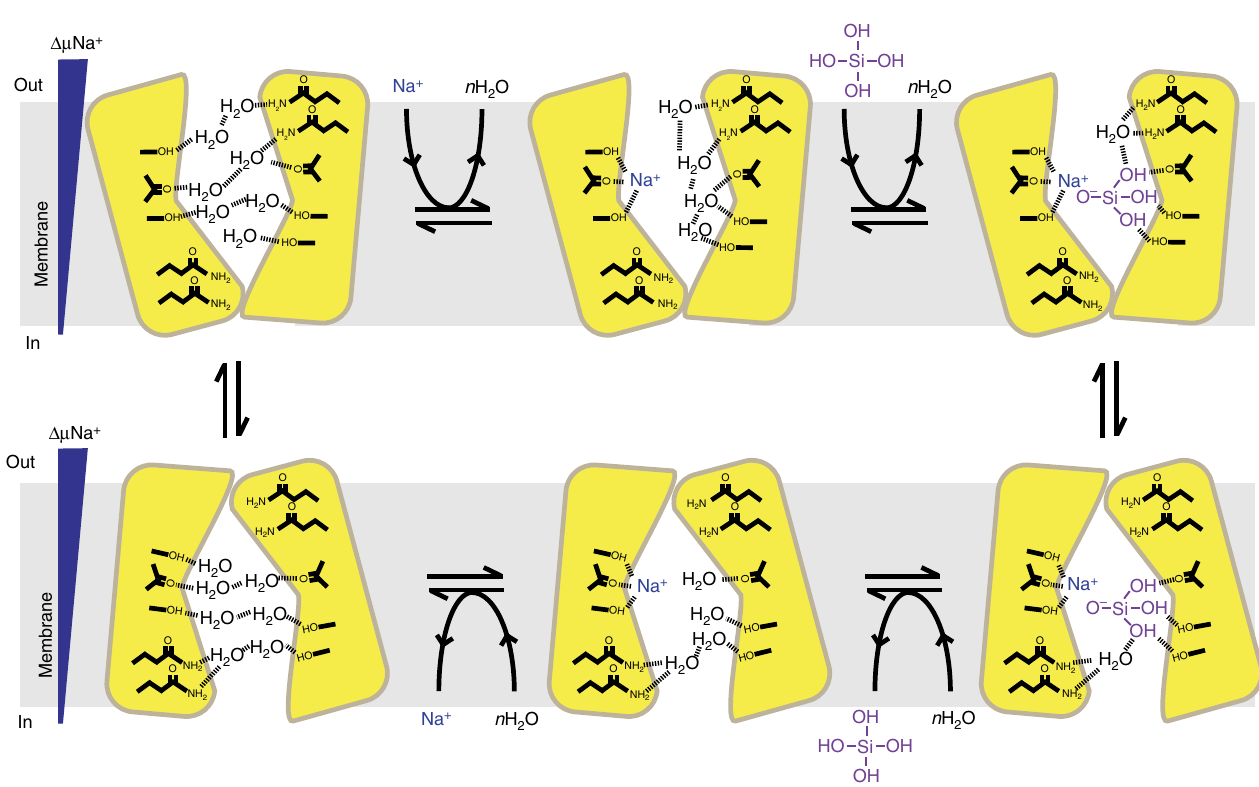
Figure 6 | Schematic cartoon (not to scale) of an alternating access mechanism for the SIT transport cycle. Sequential co-substrate binding with 1:1 stoichiometry, driven by an increase in solvent entropy, causes a change in protein conformation that exposes the binding site to the opposite side of the membrane. After substrate dissociation, the empty SIT then returns to the original conformation. Protein–substrate interactions could be mediated by either side chain or main chain